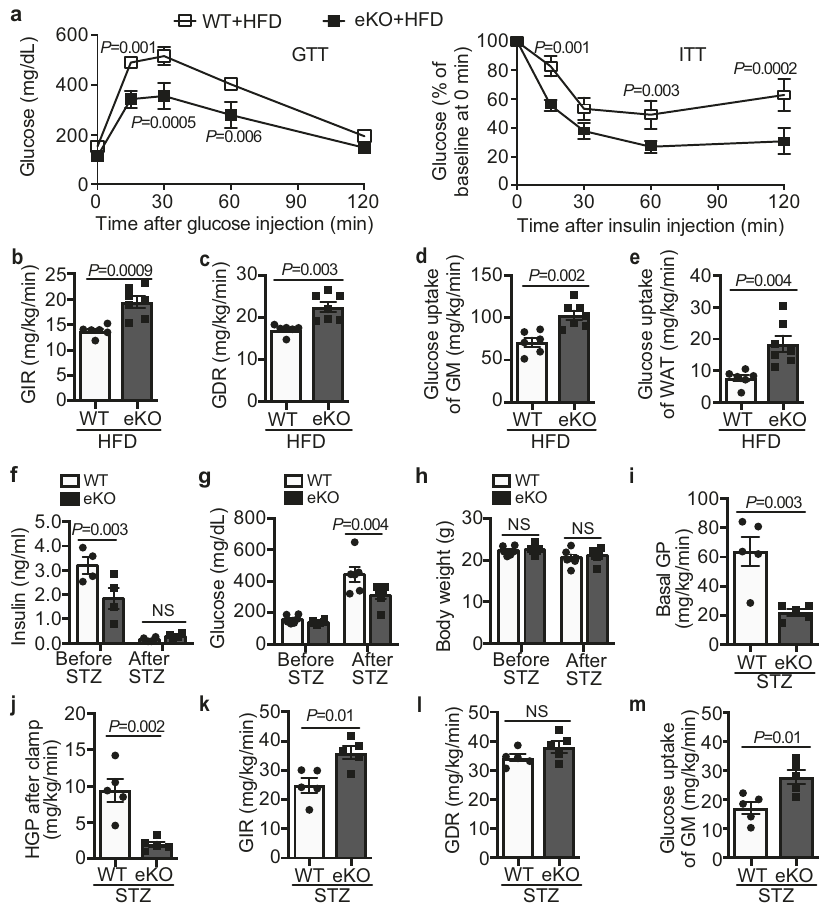
Fig. 4 LRP1 eKO mice display improved glucose response in diabetic mice. Glucose studies were performed with HFD-fed ( a – e ) or STZ-injected ( f – m ) LRP1 eKO and WT mice. a Glucose and insulin tolerance tests (GTTs, ITTs). b – e Hyperinsulinemic-euglycemic glucose clamp studies were performed in HFD-fed WT and LRP1 eKO mice for measurements of ( b ) GIR, ( c ) GDR, glucose uptake in gastrocnemius muscle (GM, d ) and white adipose tissue (WAT, e ). Results for control chow-fed mice are included in Supplementary Fig. 4. f – h Blood levels of insulin ( f ), glucose ( g ) and body weight ( h